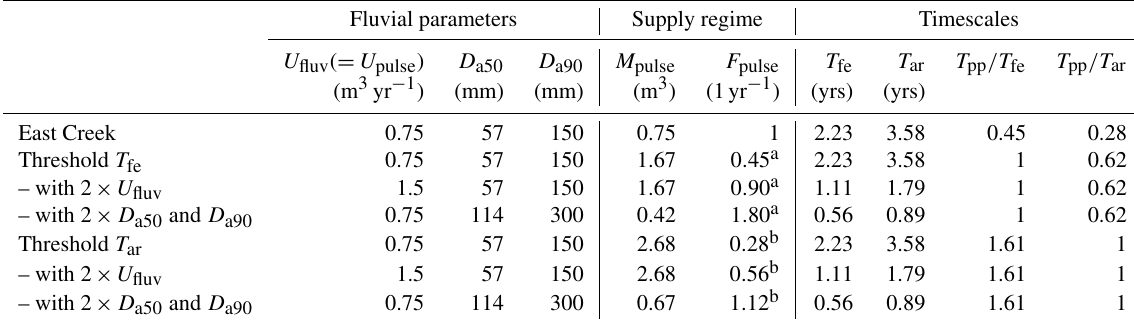
Table 4. Application of the fluvial evacuation time to the rapids reach in East Creek. The system is assumed to be in equilibrium with a matching fluvial transport rate and long-term sediment supply rate. The time of active fluvial transport is estimated to be 100hyr − 1 . We approximated the long-term fluvial transport rate U fluv with three years of data from a sediment trap below the reach. We assumed that the subsurface grain size measurements reflect the average supply GSD and the surface grain size measurements represent the long-term average state of armouring in the reach. Besides the original “East Creek” data and the two “threshold” pulse frequency fits, we assumed four more scenarios with doubled armoured grain sizes or doubled fluvial transport rates to give a rough estimate of error bounds. Fluvial parameters Supply regime